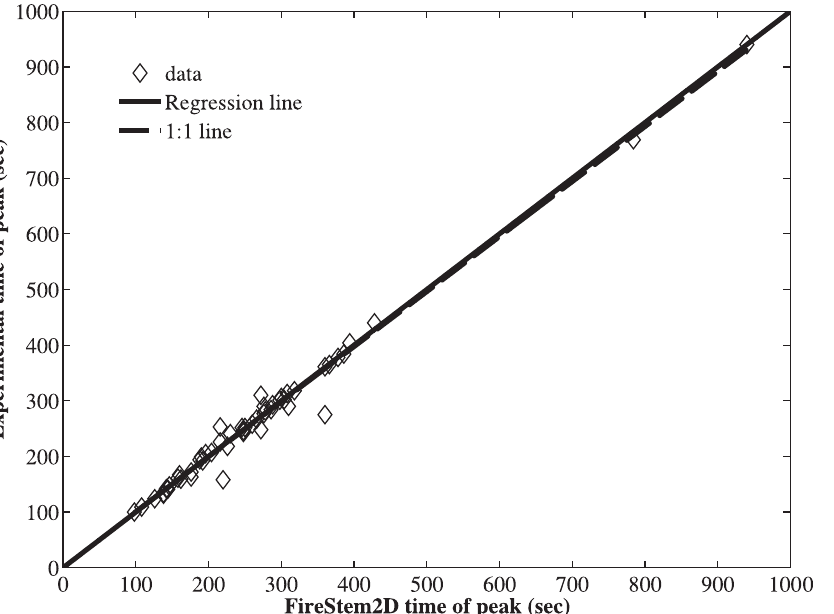
Figure 5. Scatter-plot of FireStem2D simulated versus measured peak-temperature time in all stem sections (Table 1). Dashed line marks the overall model-observation fit, solid line marks the ideal (1:1) model-observation relationship (regression line: y=0.9885( 6 0.0355)x + 1.9306( 6 10.7992), R 2 =0.98). The model is not significantly different than the observations.